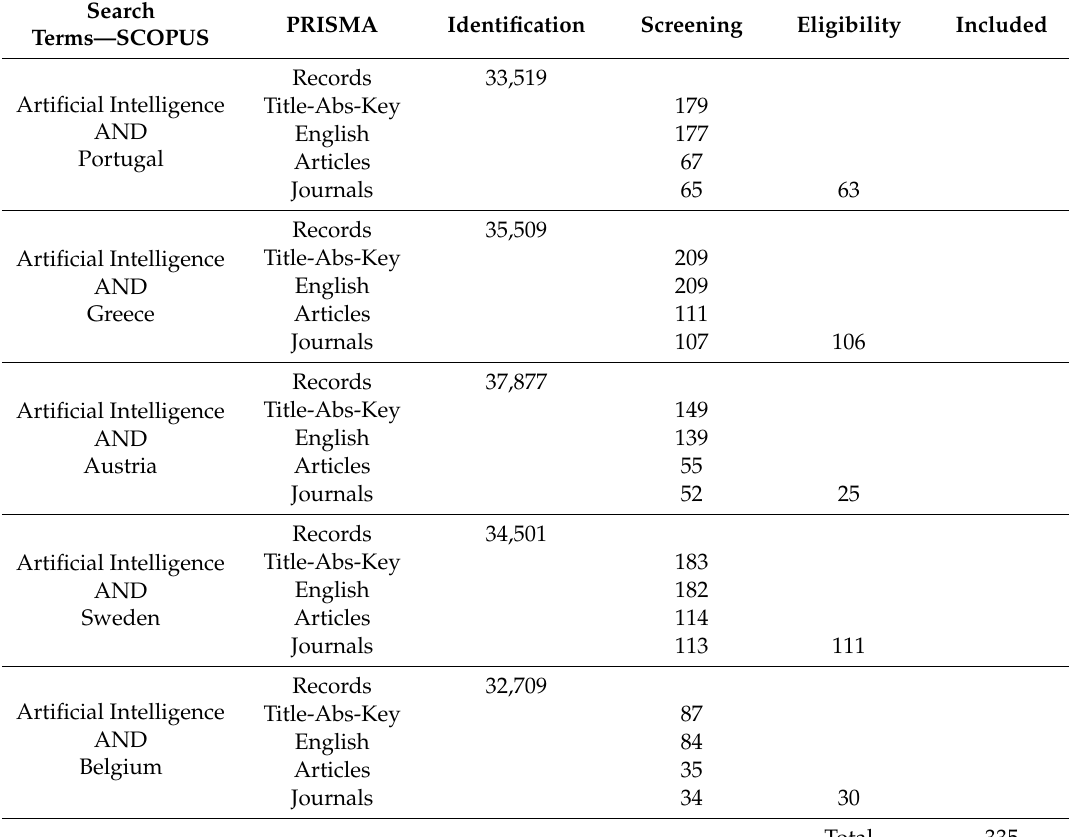
Table 2. Preferred Reporting Items for Systematic Reviews and Meta-analyses (PRISMA)